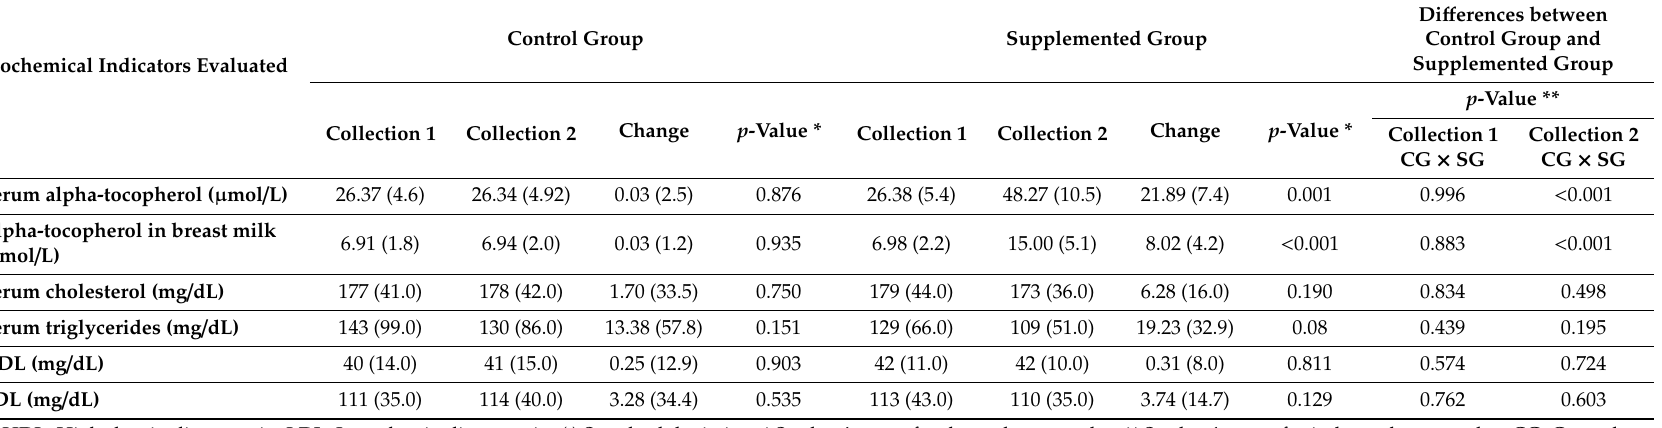
Table 2. Maternal biochemical indicators of the control and supplemented groups in collections 1 and 2, performed in the study. Natal, Rio Grande do Norte, Brazil,